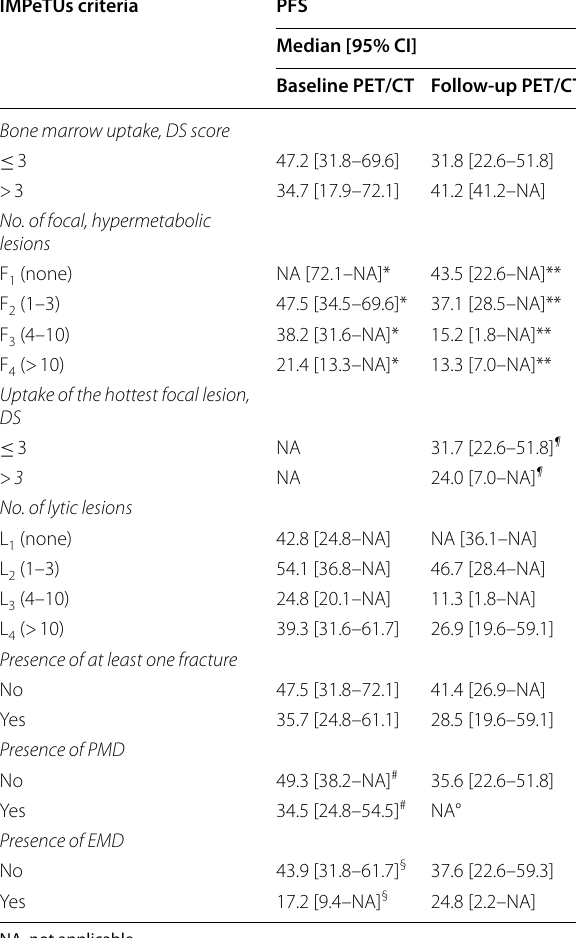
Table 4 Predictors of PFS by univariate analysis based on PET/CT results after application of